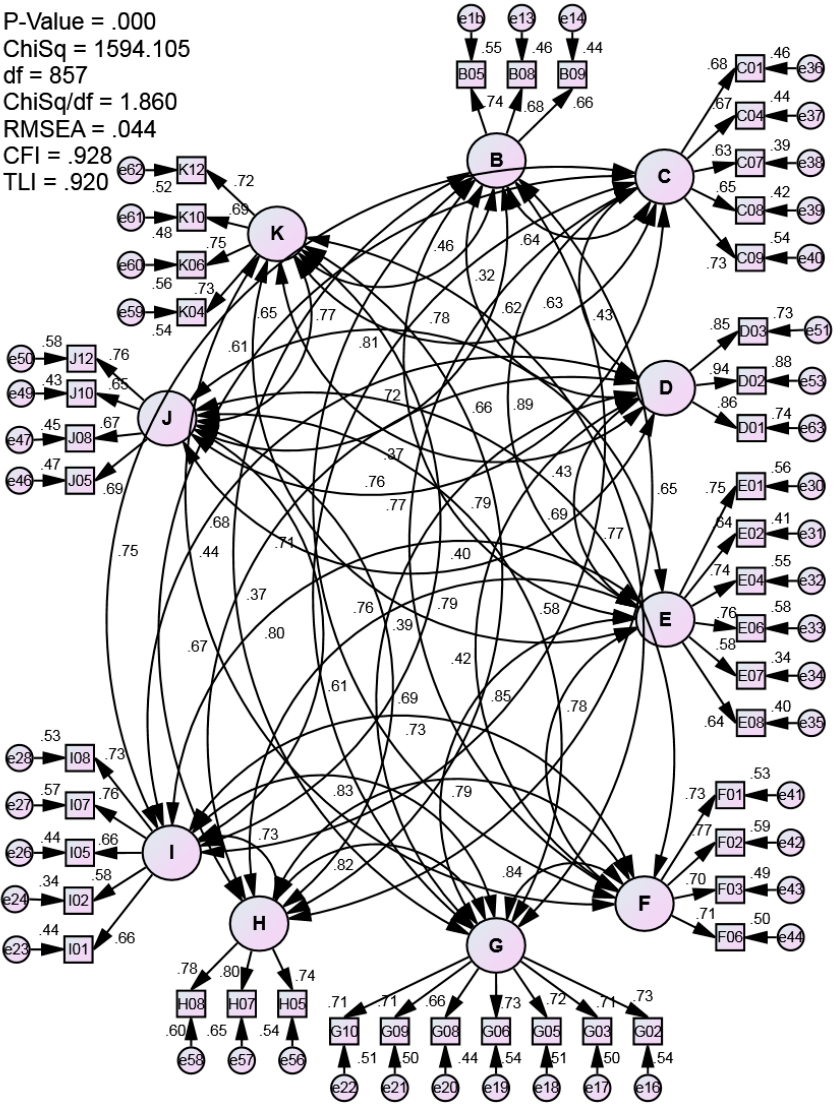
Figure 3. 10IBLP-I measurement model. Note: B = caring, C = risk-takers, D = open-minded, E = communicators, F = knowledgeable, G = thinkers, H = inquirers, I = principled, J = balance, and K = reflective.